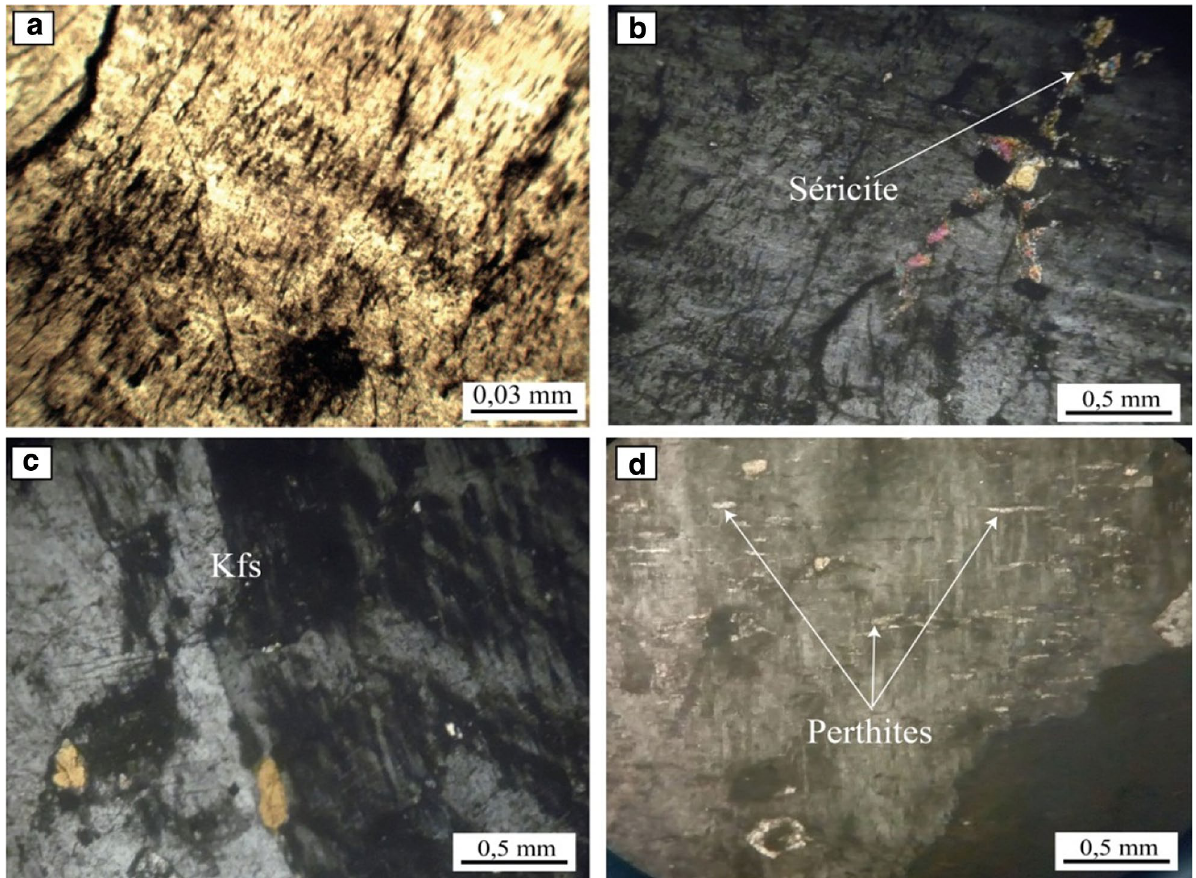
Fig. 2 Feldspar showing: a Feldspar crystal in LPNA, b Pinkish coloured sericite alteration, c Carlsbad macle, d